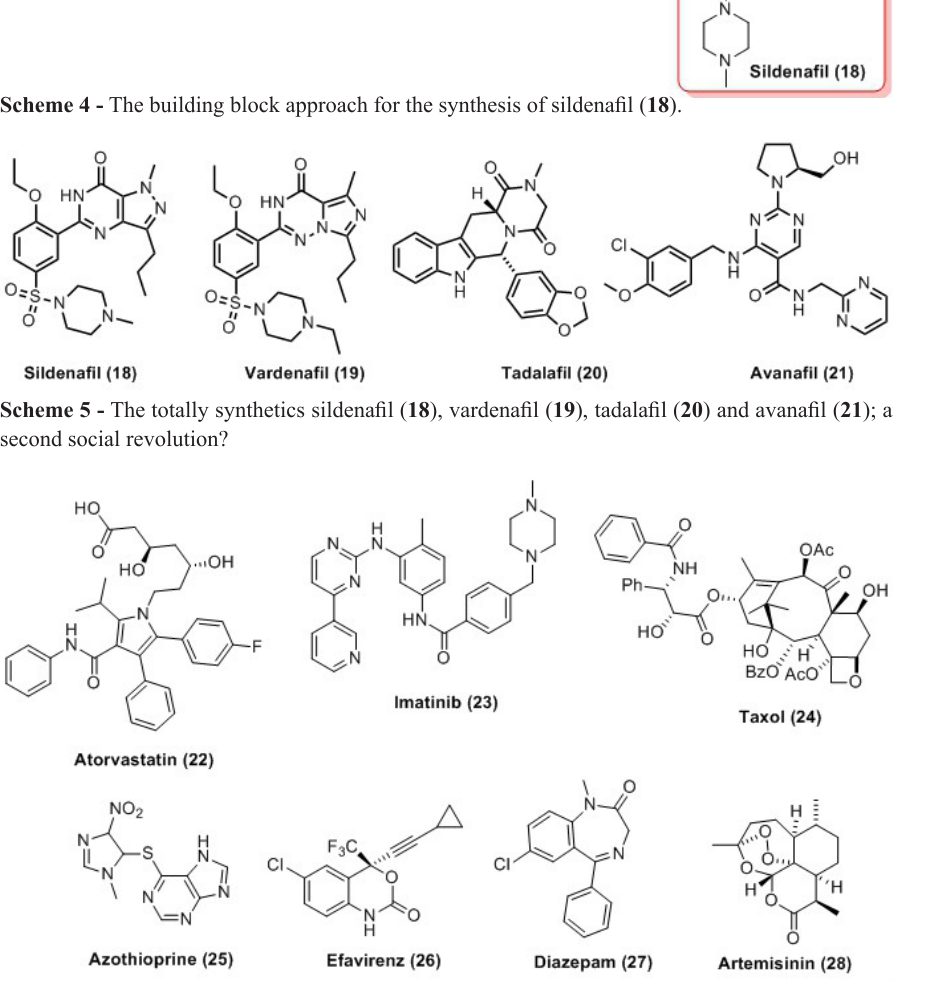
Figure 2 – Atorvastatin ( 22 ), imatinib ( 23 ), paclitaxel ( 24 ), azathioprine ( 25 ), efavirenz ( 26 ), diazepam ( 27 ) and artemisinin ( 28